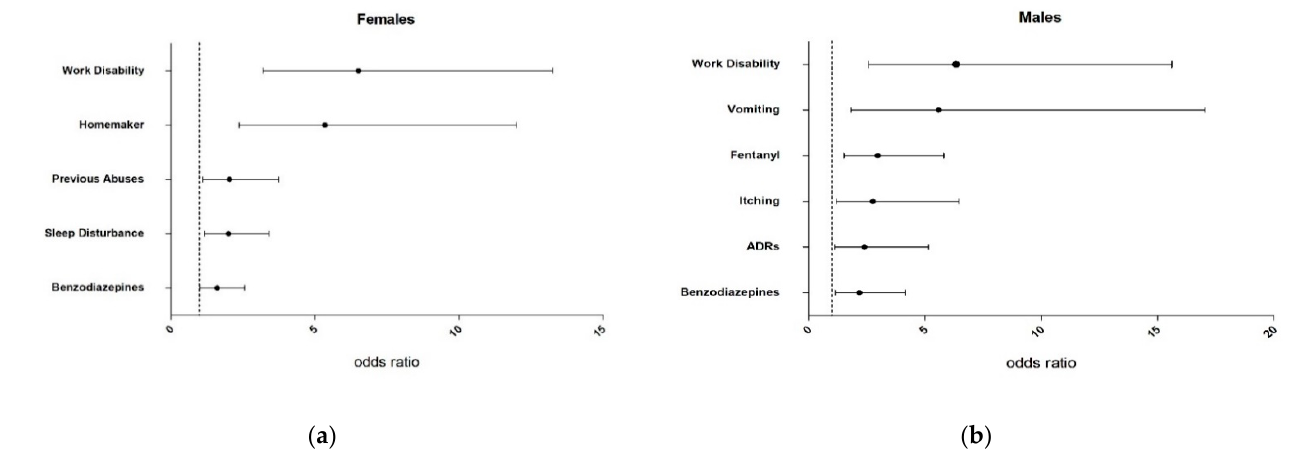
Figure 1. Flow chart of the patient selection for the study. CNCP, chronic non-cancer pain; OUD, opioid use disorder.